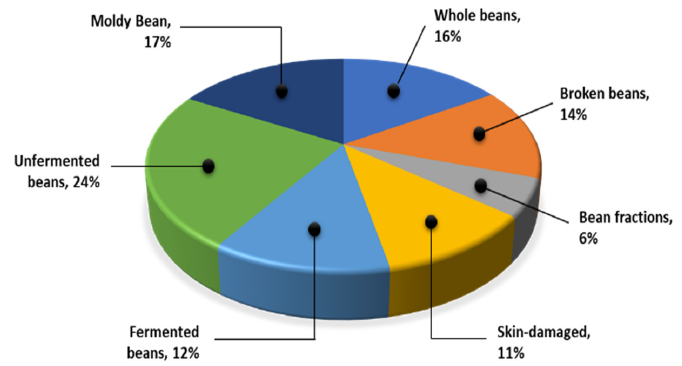
Figure 4. Distribution class of cocoa bean dataset.